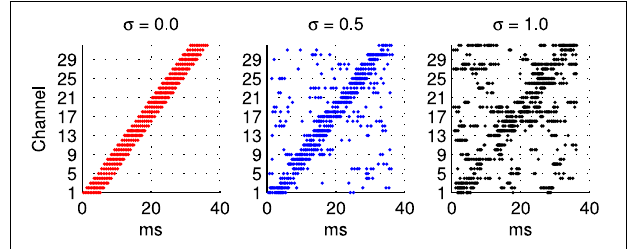
FIGURE 2 | Illustration of sample spike patterns used as probe stimuli in the hardware experiments described in section 2.1.3 to investigate the robustness of the network response to variability in the probe stimulus. In all cases these patterns of spikes are prepared off-line using a model integrate and fire neuron, a 5.5ms current pulse, and a noise current that extends over the whole stimulus period. From left to right the ratio between the noisy current the current pulse used to generate the spike in a channel increases from 0 to 1. The range illustrated is greater than that used in the experiments where the highest level of noise is σ = 0 . 45.